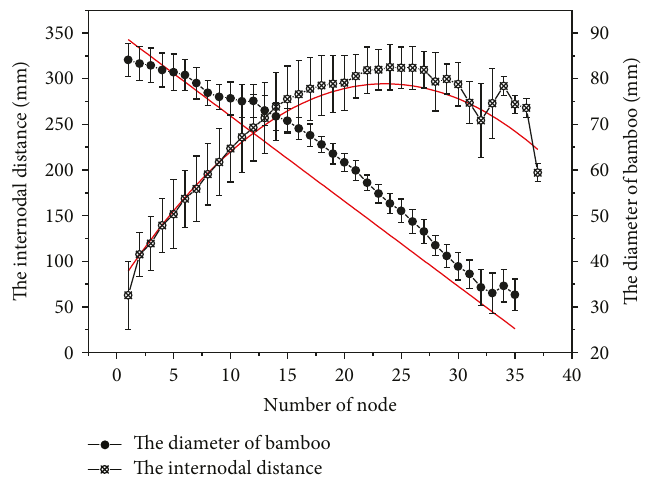
Figure 3: The distribution of internodal distance and diameter along the culm.